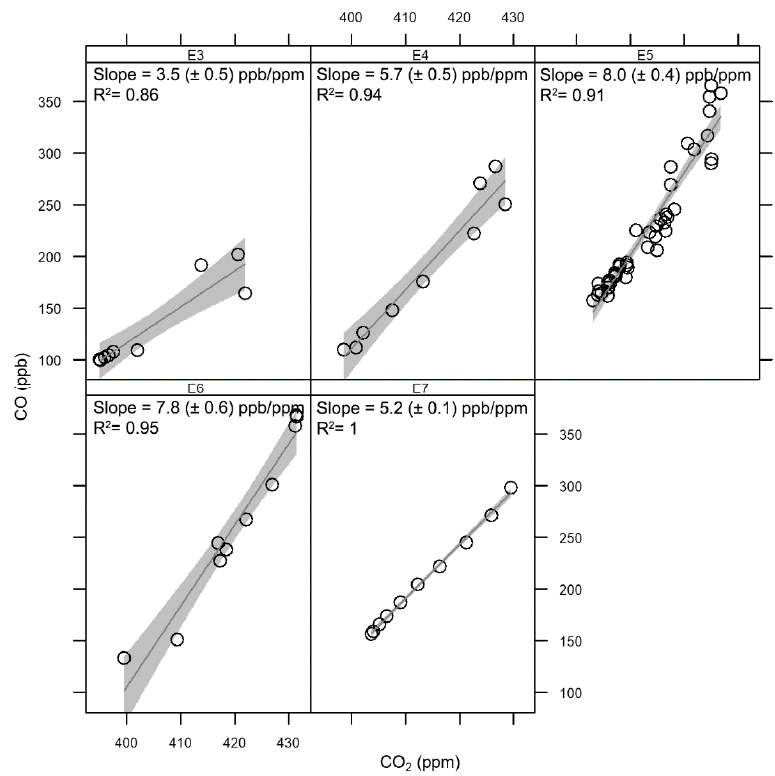
Figure 4. Linear regressions of the hourly mean mixing ratios of CO and CO 2 for the five pollution events E3–E7 (CO data not available for E1 and E2). The slope and coefficient of determination R 2 are given. The shaded areas around the regression lines represent the range in which the true regression line lies at a certain level of confidence (95% in the plot). The slope of the regressions corresponds to CO/CO 2 emission ratios.